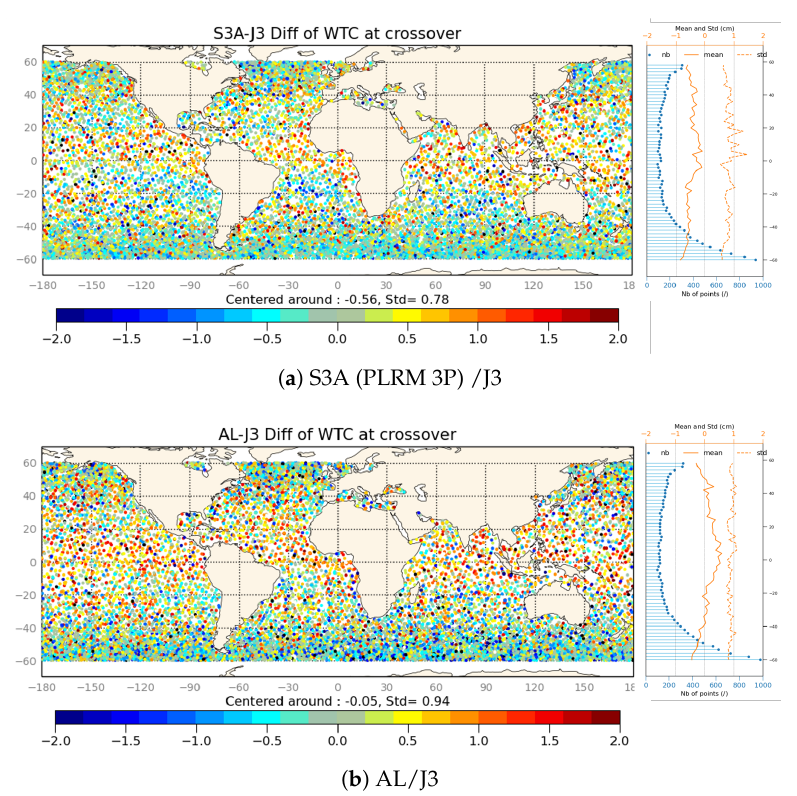
Figure 15. Maps of Wet Troposphere Correction (WTC) differences at S3A/J3 ( a ) and AL/J3 ( b ) crossover